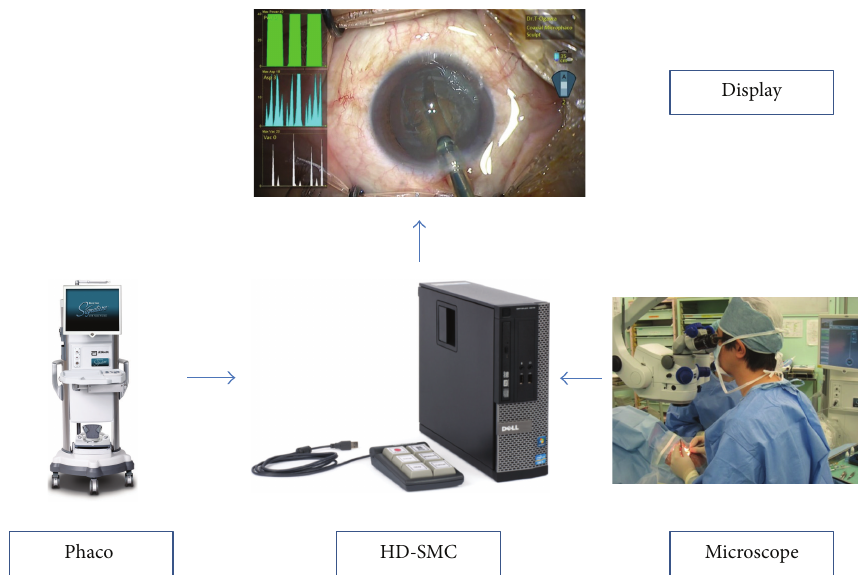
Figure 1: The High-Definition Surgical Media Center (HD-SMC) used with a phacoemulsification system.